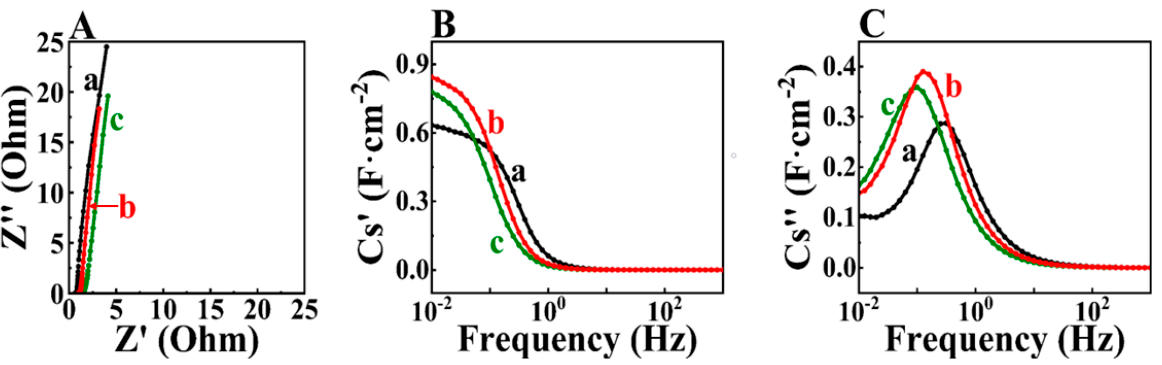
Figure 8. ( A ) Nyquist plot of Z*, ( B , C ) frequency dependences of ( B ) C s ′ and ( C ) C s ″ for (a) composite 1, (b) composite 2 and (c) composite